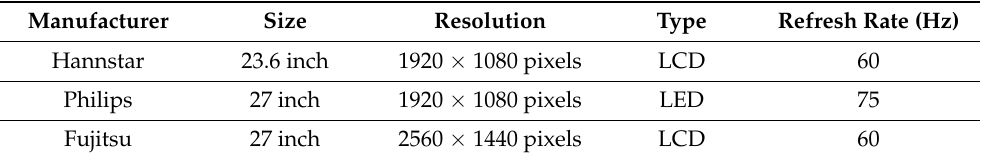
Table 3. Specifications of monitors used for WSI